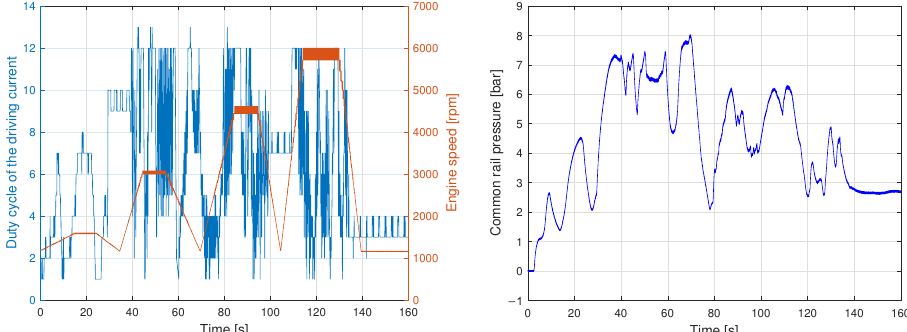
Figure 6. Inputs and output data used to fit the high-order ARX model (data are sampled every 1